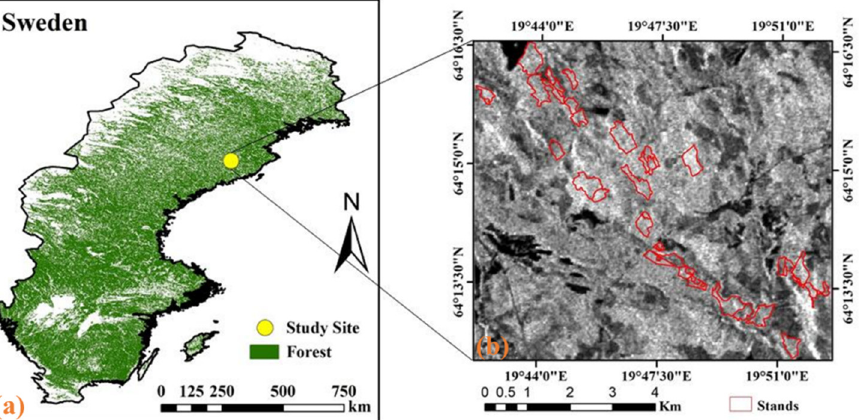
Figure 1. Geographical location of the study area. ( a ) The location of study area in Sweden. ( b ) The distribution of forest stands.